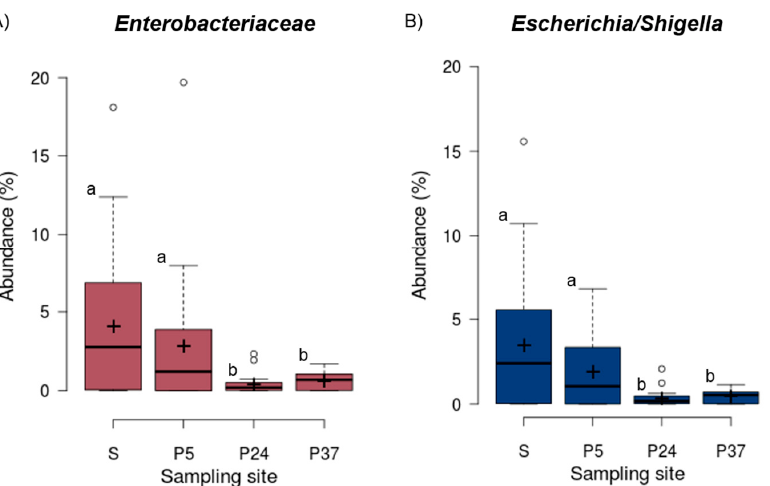
Figure 3. Box and whisker plots showing the abundance variation of Enterobacteriaceae ( A ) and Escherichia/Shigella ( B ) across the sampling sites. The thick lines represent the median; the box upper and lower limits indicate the 25th and the 75th percentiles, respectively; the whiskers indicate the data that lie beyond the 5th percentile (lower whisker) and the 75th percentile (upper whisker); and the dots represent the outliers. The different letters indicate differences between the mean values of different groups.